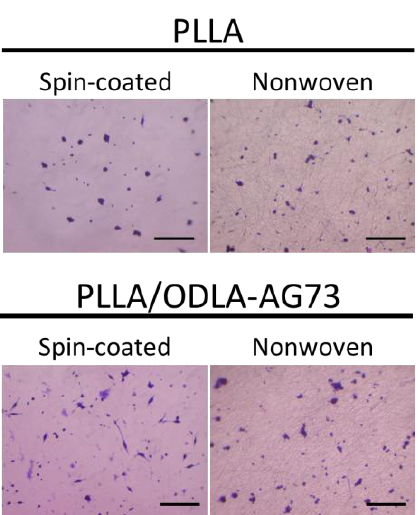
Figure S2. Adhesion and neurite outgrowth of PC12 cells on spin-coated film and on electrospun nanofibrous nonwoven PLLA or PLLA/ODLA-AG73 (scale bar = 200  m). Spin-coated films were prepared on a glass slide with a spin coater as follows: 10 w/v% HFIP solution of PLLA or PLLA/ODLA-AG73 (including 3 w% ODLA-AG73 conjugate) was dropped on a slide and spread with a spin coater (3,000 rpm, 20 s). Nanofibrous nonwoven PLLA or PLLA/ODLA-AG73 and nanofibrous conduits were fabricated on the slide by electrospinning. PC12 cells were primed with NGF for 24 h, then, added to the samples. The samples were incubated at 37 °C for 24 h in Dulcecco’s modification of Eagle’s medium (DMEM) containing NGF. On spin-coated film, PLLA/ODLA-AG73 promoted the adhesion and neurite ourgrowth of PC12 cells. On nanofibrous nonwoven PLLA and PLLA/ODLA-AG73, the PC12 cells were slightly spread and more differentiated on PLLA/ODLA-AG73 than on